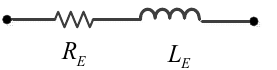
Figure 2. Equivalent circuit of electromagnetic